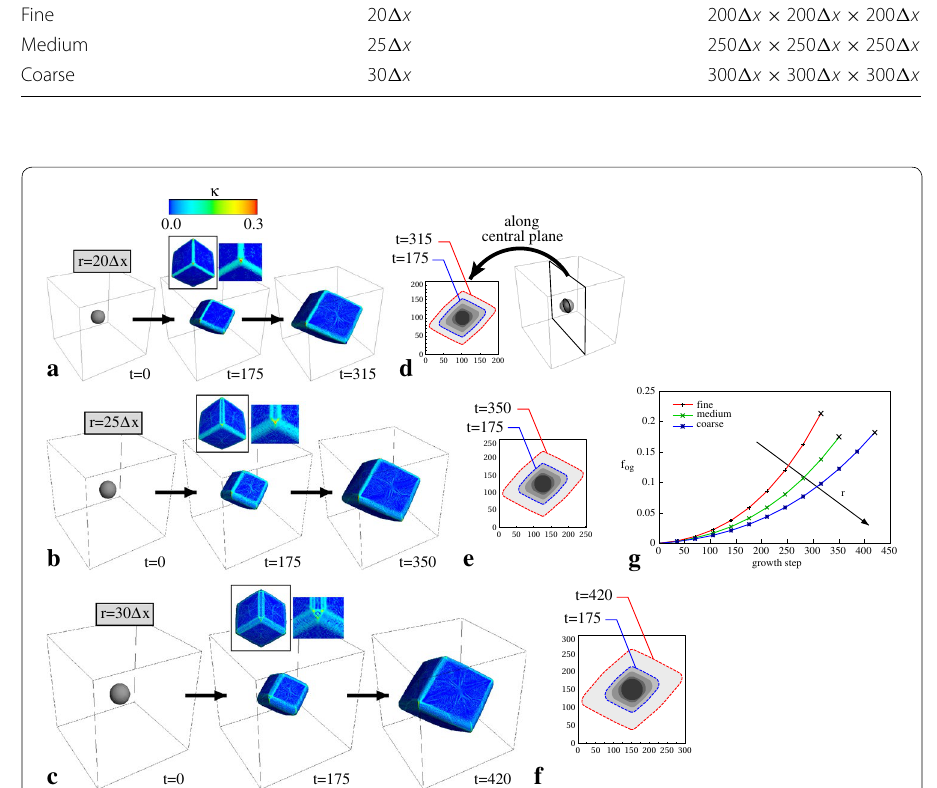
Fig. 4 a – c Unconstrained monograin growth from spherical nuclei (in gray ) of initial grain size r = 20 (cid:31) x , r = 25 (cid:31) x , and r = 30 (cid:31) x . The zoomed outlet pictures of the crystal isosurfaces at growth step t = 175 illustrate the varying sharpness of corner and edges for different initial grain sizes. The colormap defines the curvature κ of isosurfaces at t = 175 . Simulations are ended when grains reach their maximum size until which they remain confined in the respective domains. d – f Growth contours of the crystal interfaces along the central plane at a series of growth steps. Interfaces at intermediate growth step ( t = 175 , for all grain sizes) are highlighted in dotted blue . Interfaces at the final growth step (different for different grain size) are shown in dotted red . g Plot of overgrowth volume fraction f og with growth step for different grain sizes. The overgrowth kinetics is inversely dependent (non-linear) on the initial grain size